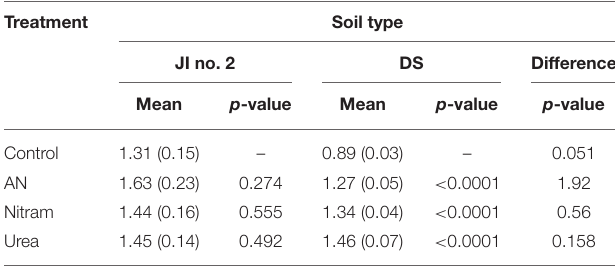
TABLE 3 | Mean % total nitrogen in leaves grown in JI no. 2 and degraded soil (DS) a . Treatment